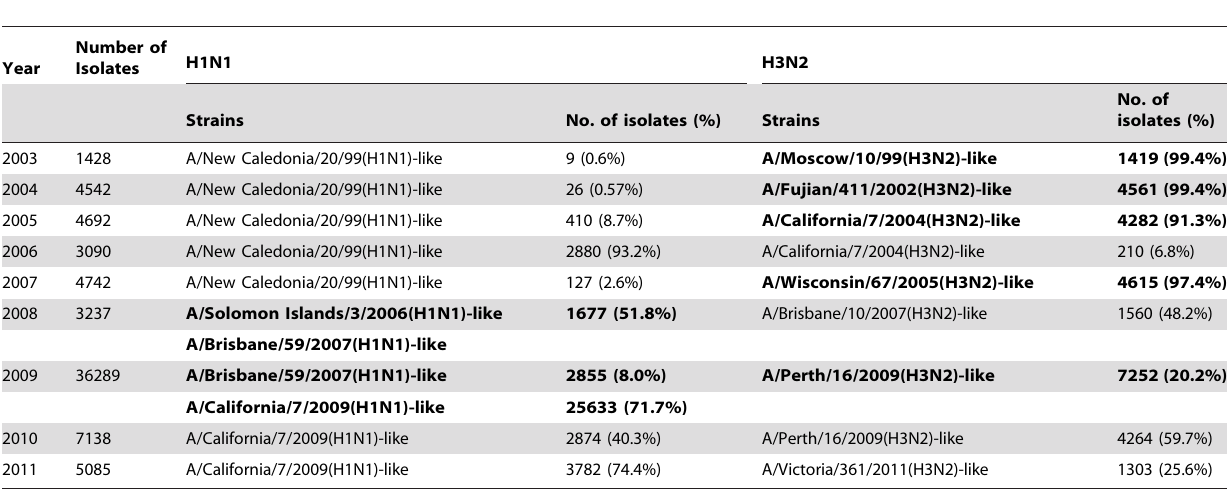
Table 1. Circulation of influenza A strains reflected by proportion of influenza isolates submitted to the virology laboratory of the Department of Health in Hong Kong